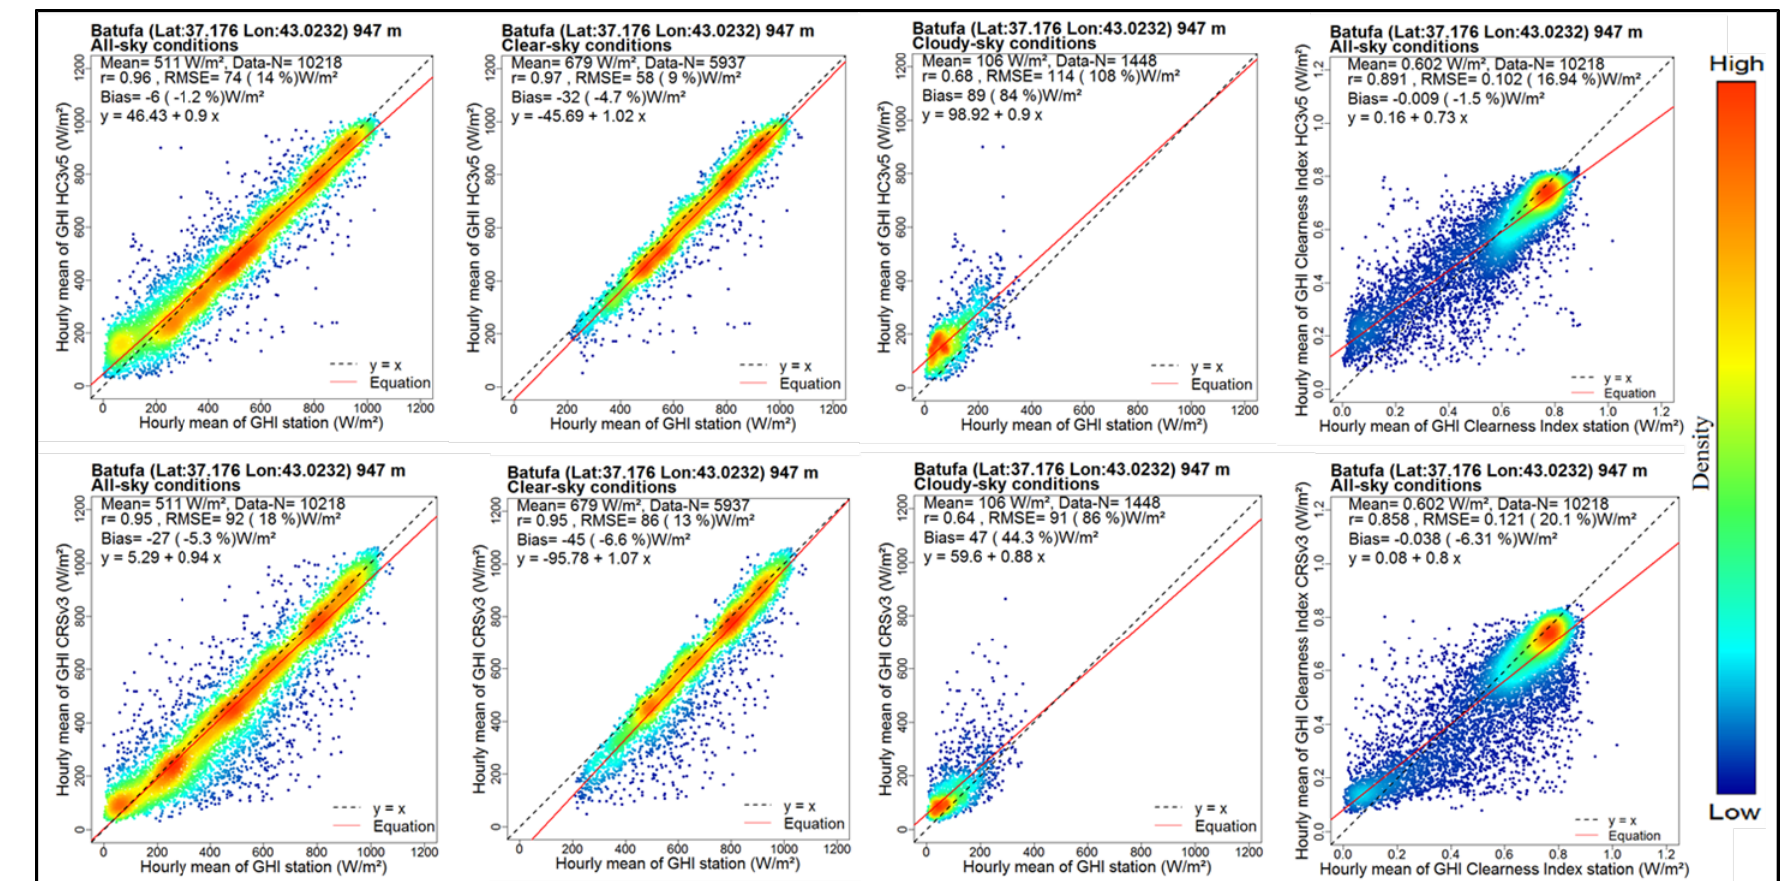
Figure 9. Scatter plot between hourly GHI ground measurements and SDDs (HC3v5 and CRSv3) for Batufa station for all-sky, clear-sky and cloudy-sky conditions and the clearness index.